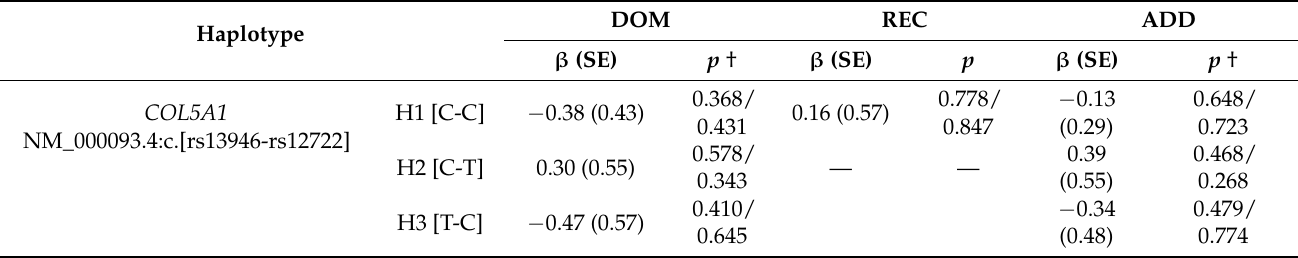
Table 5. The COL5A1 NM_000093.4:c.[rs13946-rs12722] association with injury status.